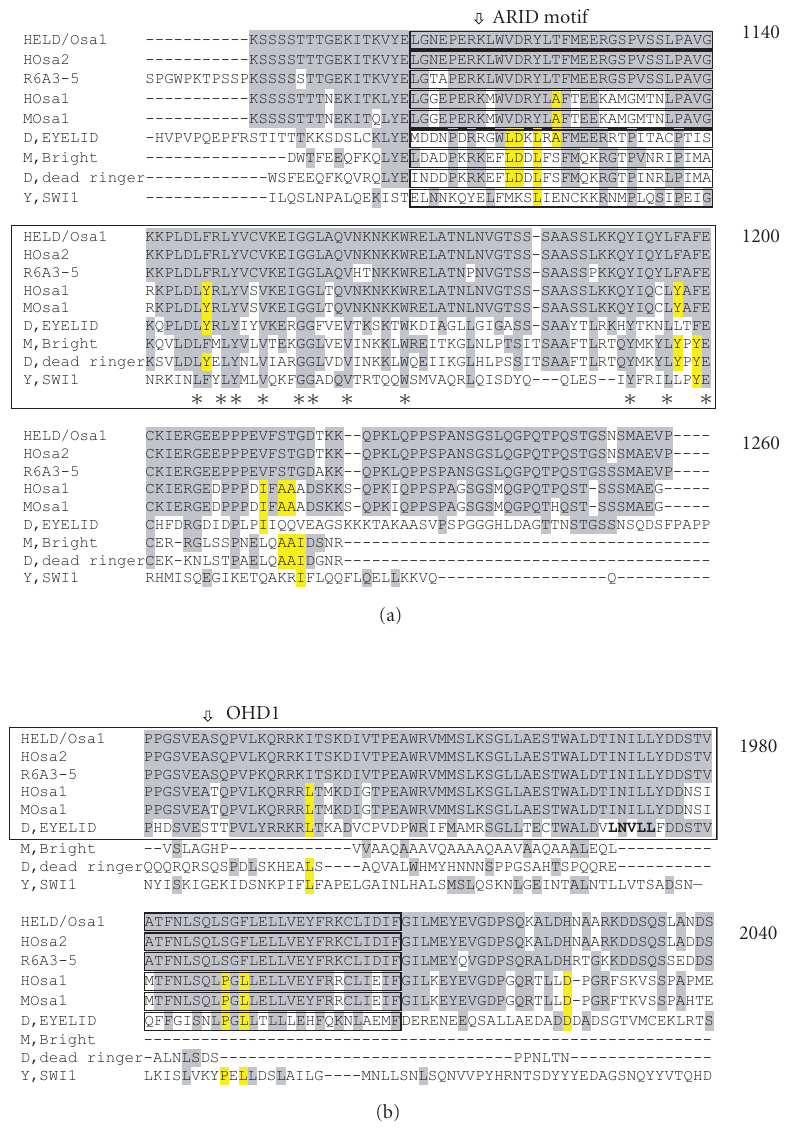
Figure 2: Alignments of conserved domains of ARID proteins by CLUSTALW program . (a) ARID motif alignment among di ff erent species is shown. (b) OHD-1 (Osa hoomology domain-1) motif alignment. (c) OHD-2 (Osa hoomology domain-1) motif alignment. Conserved aa residues are shown by underlining. Identical residues are indicated in grey. H: human, r: rat, M: Mouse, d: Drosophila, Y: yeast (hELD/OSA1 or hOsa2: human homolog of